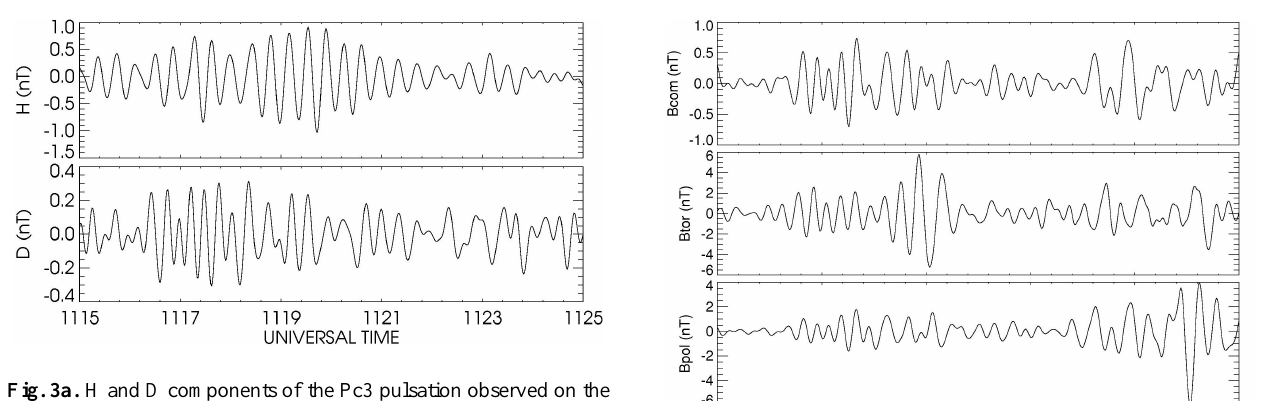
Fig. 3a. H and D components of the Pc3 pulsation observed on the ground at Hermanus on 15 February 2003.